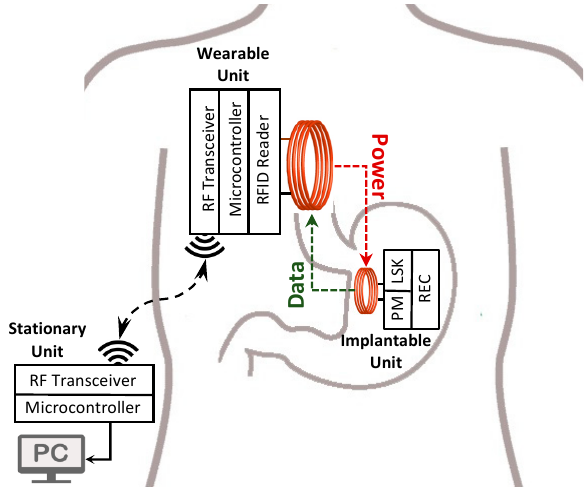
Figure 1. The block diagram of the near-field communication system for simultaneous wireless power transfer and telemetric acquisition of the gastric bioelectrical activity is